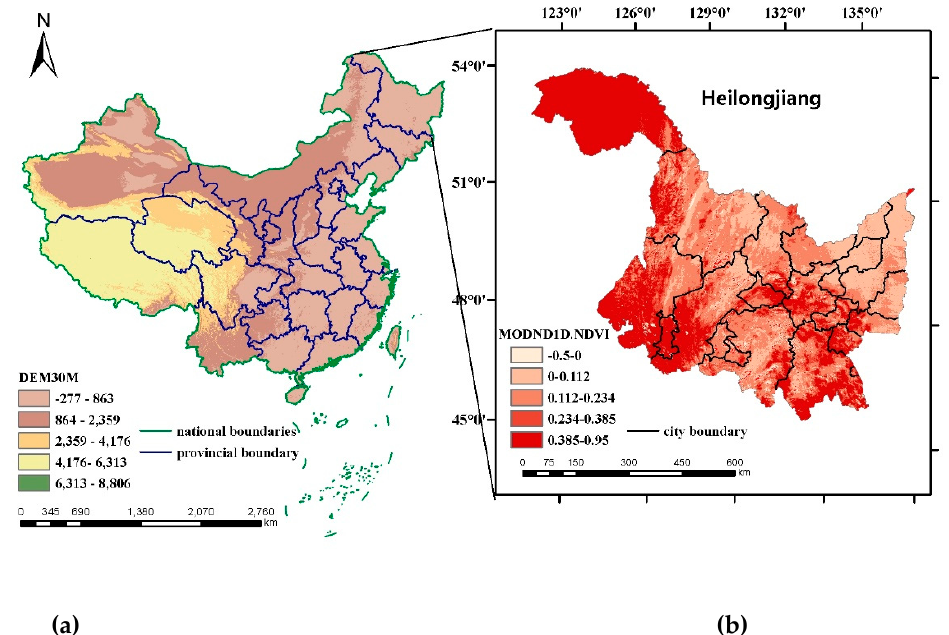
Figure 1. Study area. ( a ) China. The Chinese map overlays the digital elevation model (DEM) 30 M base map. ( b ) Shape, latitude, and longitude of Heilongjiang. Heilongjiang Province overlays the moderate resolution imaging spectroradiometer (MODIS) China 500 M normalized difference vegetation index (NDVI) for dairy products.